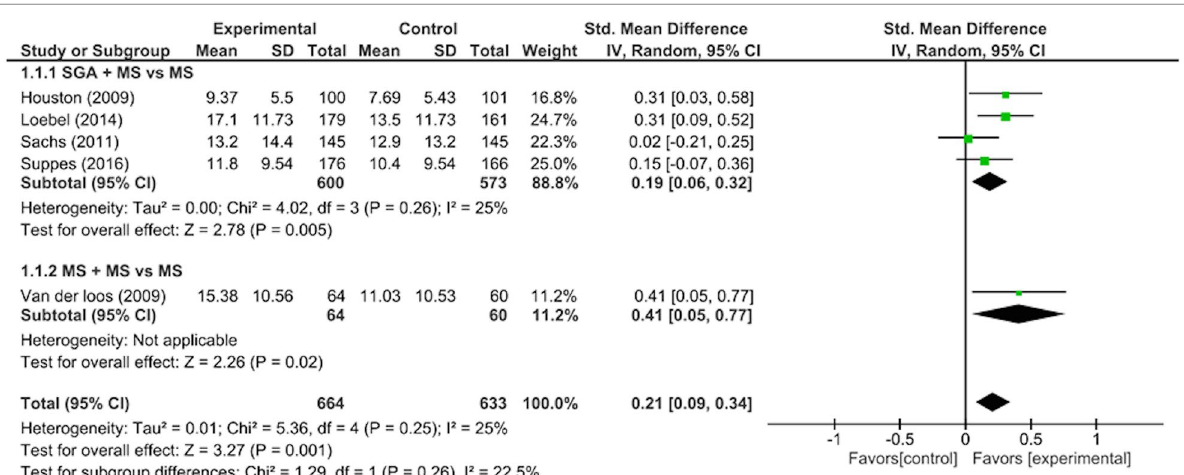
Fig. 4 Forest plot of post-intervention treatment effect sizes for improvement in depressive symptoms. Subgroup analysis of types of combination therapy. CI, confidence interval; SD, standard deviation; MS, mood stabilizers, including lamotrigine, lithium, and valproate; SGA, second-generation